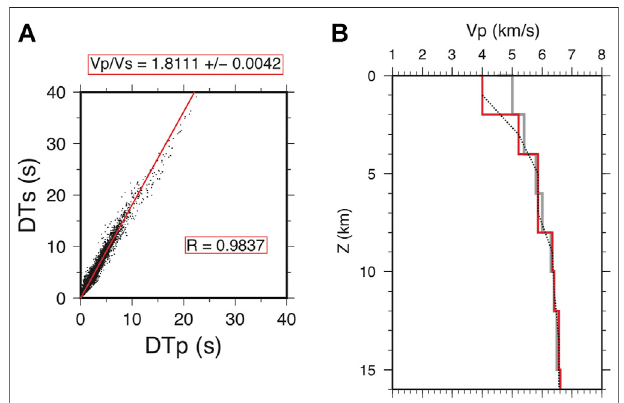
FIGURE5|(A) Wadati(1933) diagramcomputed onalltheearthquakes with up-going ray-paths to the stations. For each event, DTp and DTs are the differences between P- and S-phase arrival times, respectively, at couples of stations.The Vp / Vs valueistheslopeofthestraightredline,while R isthe correlation coef fi cient of the linear regression (B) Starting (dark gray) and fi nal (red) P-wave 1-D velocity model computed using the VELEST code (Kissling et al.,